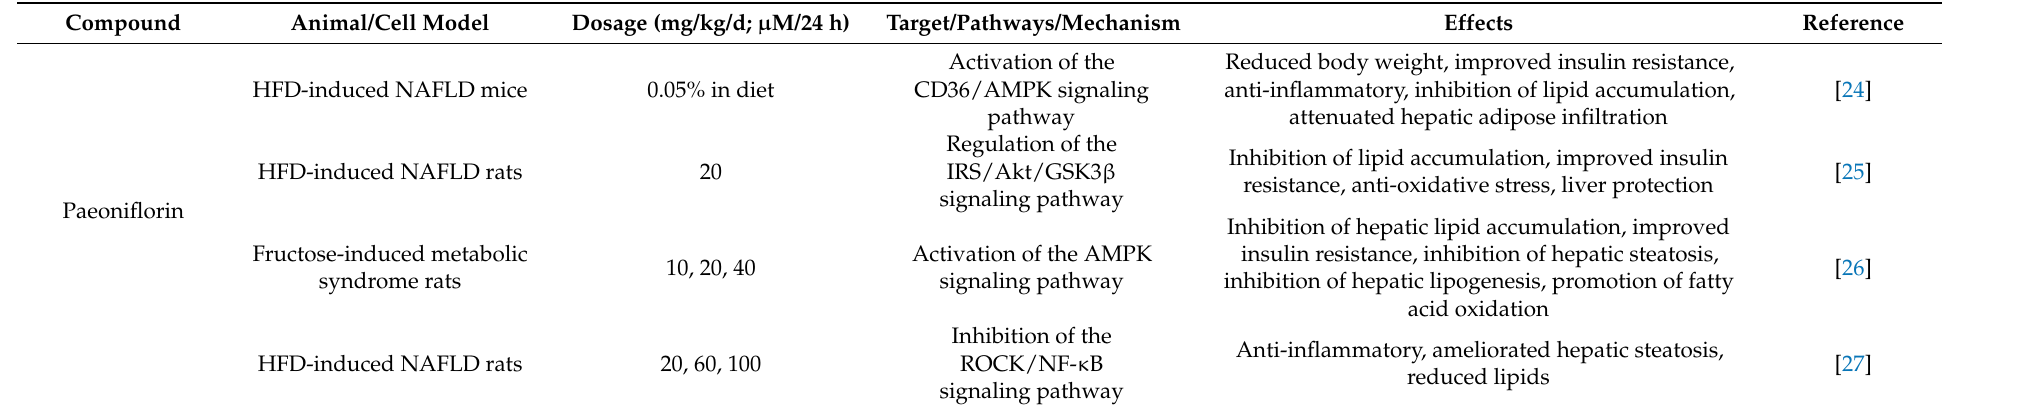
Table 2. The effects and mechanisms of 43 terpenoids on NAFLD, from recent